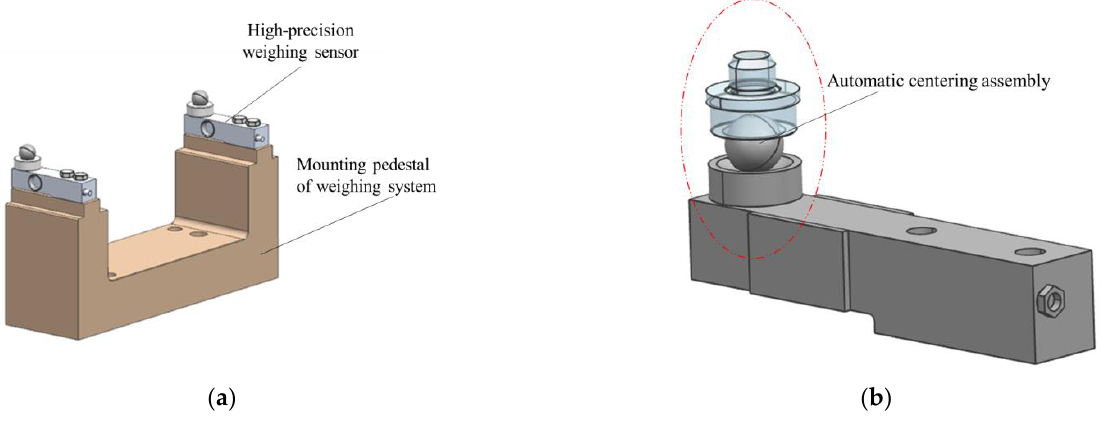
Figure 9. ( a ) Sensor measurement system model; ( b ) automatic centering assembly model.